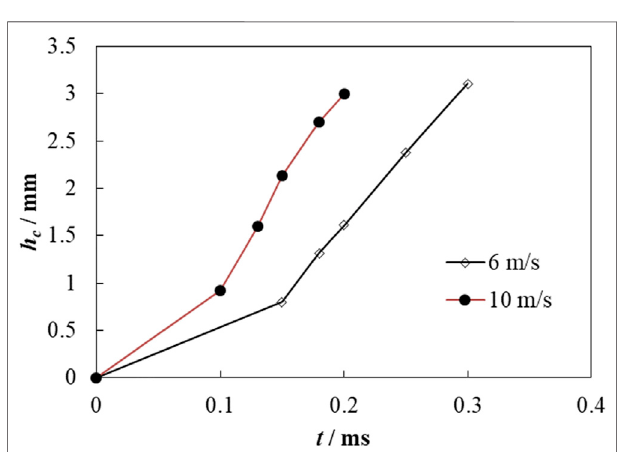
FIGURE 10 | Dimensionless edge jet height of hollow droplet and continuous dense droplet at impact velocities of 6 and 10 m s − 1